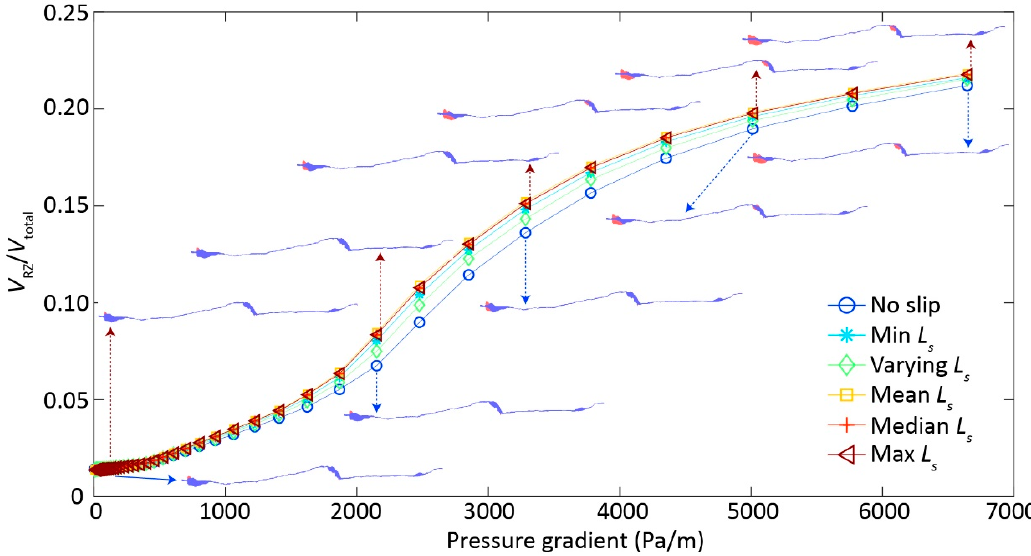
Figure 3. The recirculation zone volume ratio ( V RZ / V total ) increases with pressure gradient for six cases with a variety of slip lengths L s : case 1—no slip length with L s equal to 0; case 2—minimum L s assigned in the case 3; case 3—varying L s depending on aperture based on [20,21]; case 4—mean L s assigned in the case 3; case 5—median L s assigned in the case 3; and, case 6—maximum L s assigned in the case 3, where V RZ is circulation volume, V total is the total fracture volume. Insets illustrates the spatial distribution of recirculation zones with increasing pressure gradient for the no-slip case 1 (blue arrows) and case 6 (brown arrows).